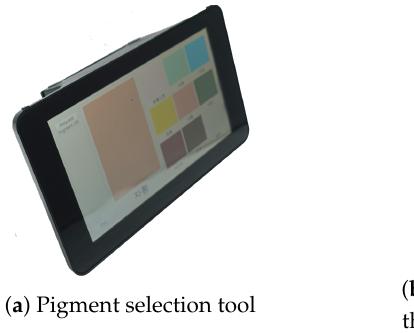
Figure 11. Pigment selection tool and its working example. The pigment selection tool is a Raspberry Pi equipped with a touch screen and a battery. It communicates with the PC through Wi-Fi, which removes the restrictions on the location of the